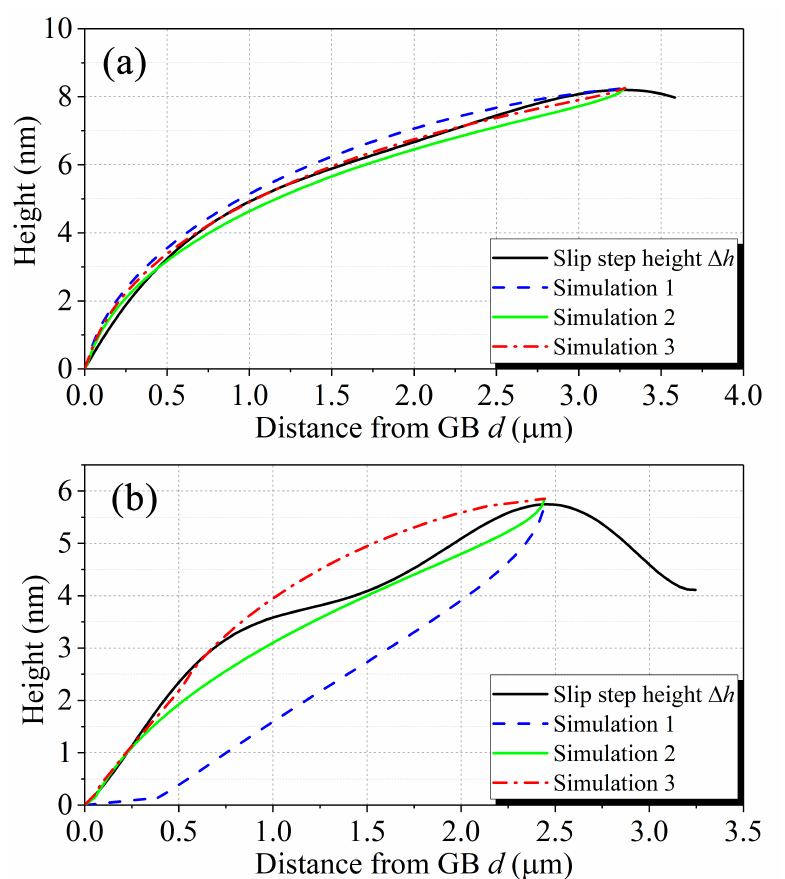
Figure 8. ( a ) simulation of slip step height profile for Ni with different discrete dislocation pile-up simulation conditions ( b GB is always the same as b In ). Simulation 1: without free surfaces. Simulation 2: with two free surfaces. Simulation 3: with two free surfaces and a non zero material dependent critical force F c = 0.003